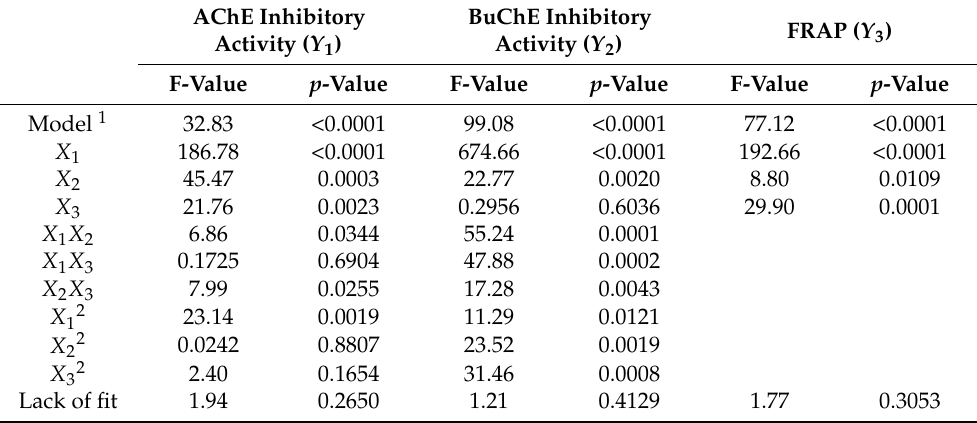
Table 3. ANOVA results for dependent variables. AChE Inhibitory